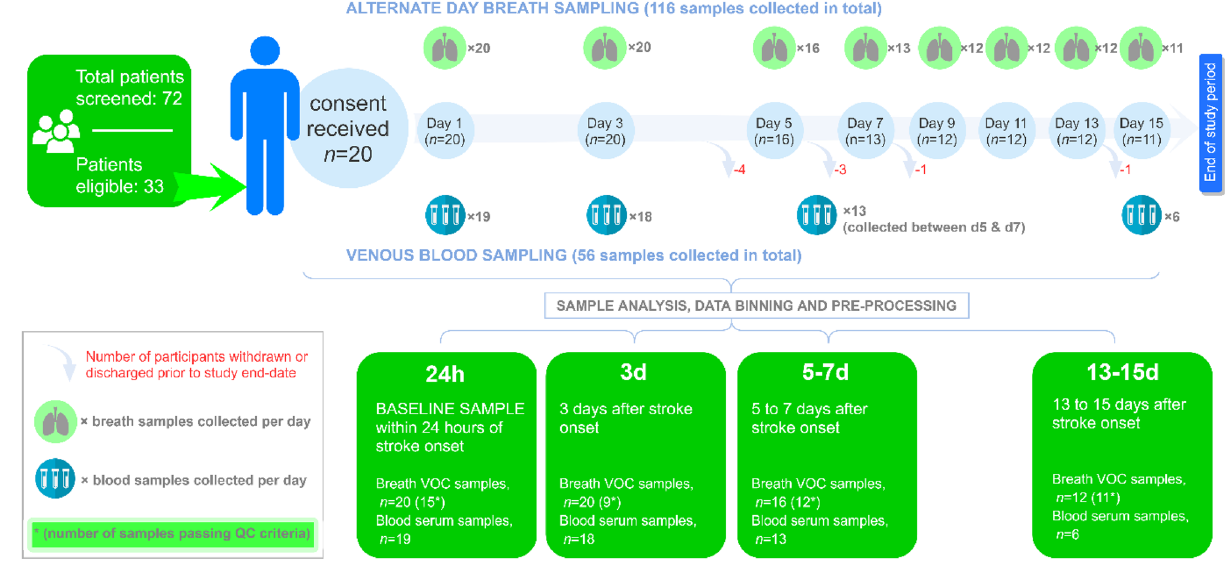
Figure 1. Study assessment overview depicting the type and number of samples